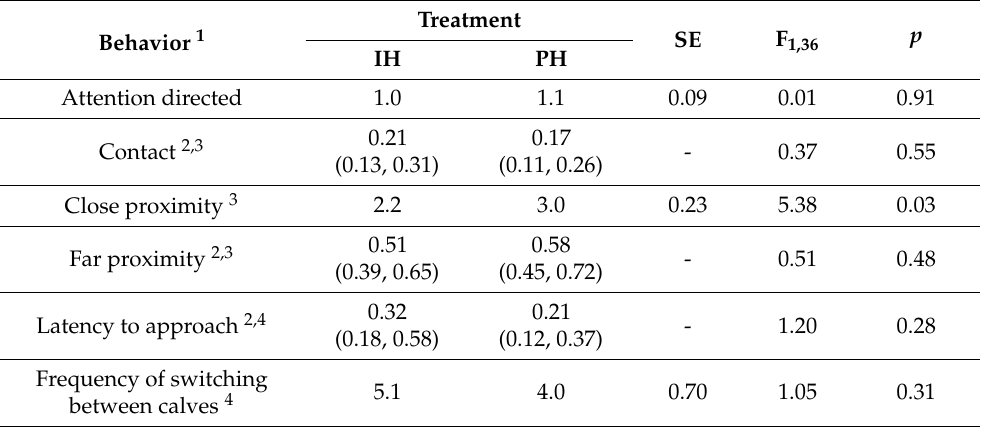
Table 2. Effects of housing calves individually (IH; n = 20) or in pairs (PH; n = 20, one focal calf/pair) from birth on total duration of behavior directed toward either stimulus calf in a social preference test conducted at 4 weeks of age (29.3 ± 1.9 d of